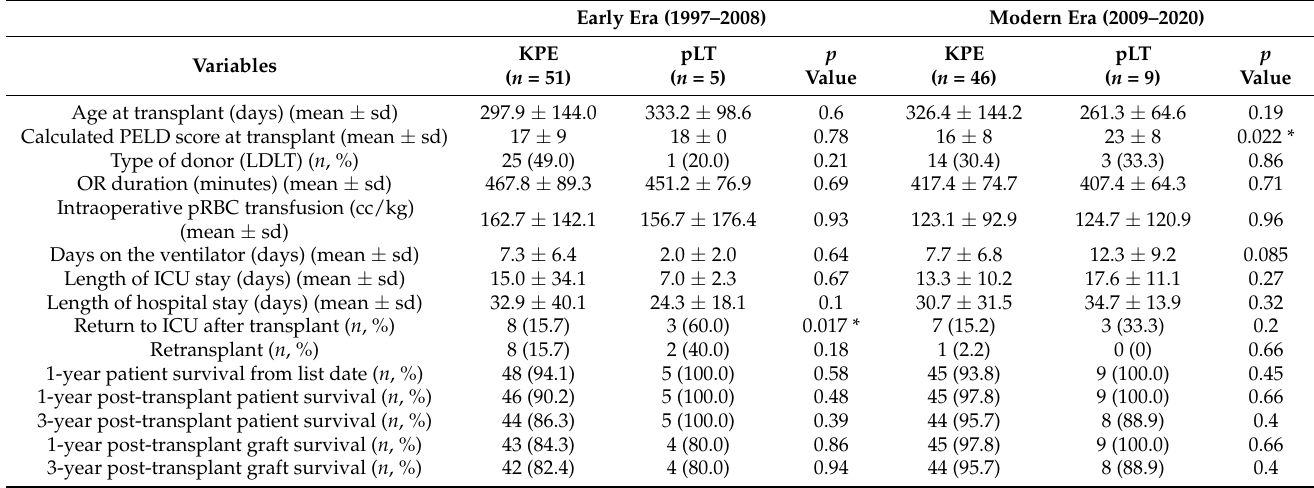
Table 4. Post-transplant comparison of patients transplanted after KPE or as pLT based on era: transplant-related data and post-transplant outcomes. Legend: (*) represents a statistically significant